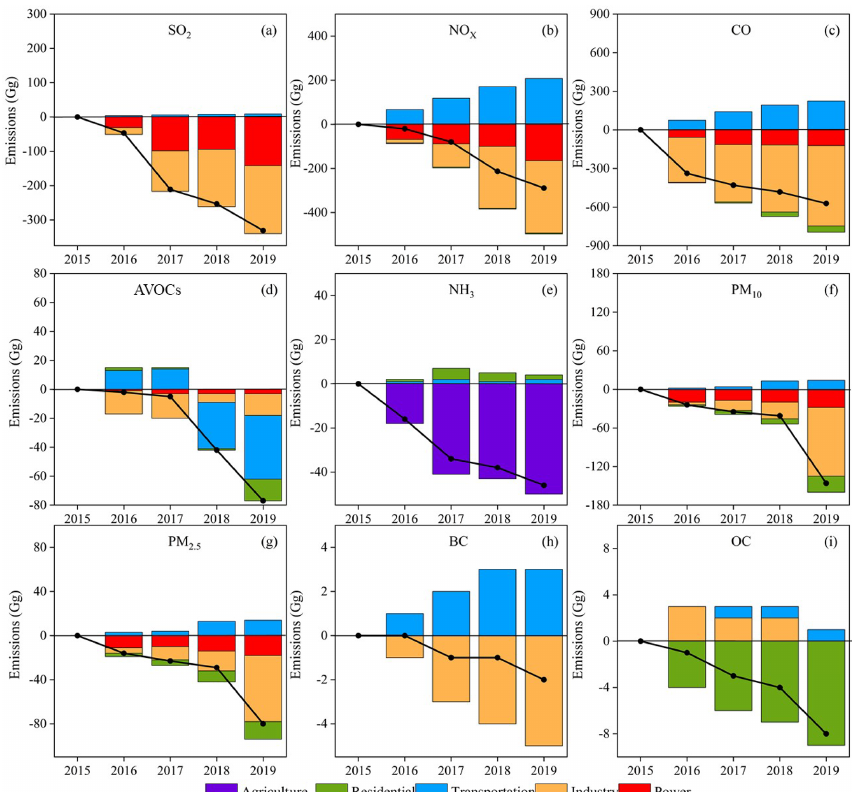
Figure 3. Changes in emissions by sector and year. The species include (a) SO 2 , (b) NO x , (c) CO, (d) AVOCs, (e) NH 3 , (f) PM 10 , (g) PM 2 . 5 , (h) BC, and (i) OC. The 2015 emissions are subtracted from the emission data for each year to represent the additional emissions compared to 2015